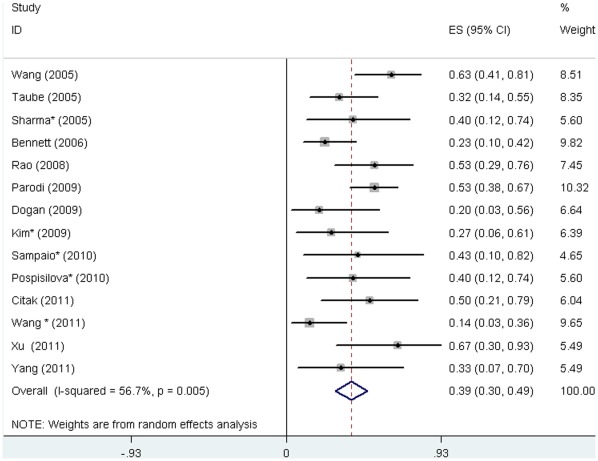
Complete response rate to rituximab in children with ITP.The diamond indicates the pooled complete response rate (39%). Test of heterogeneity: I2 = 56.7%, P = 0.005.